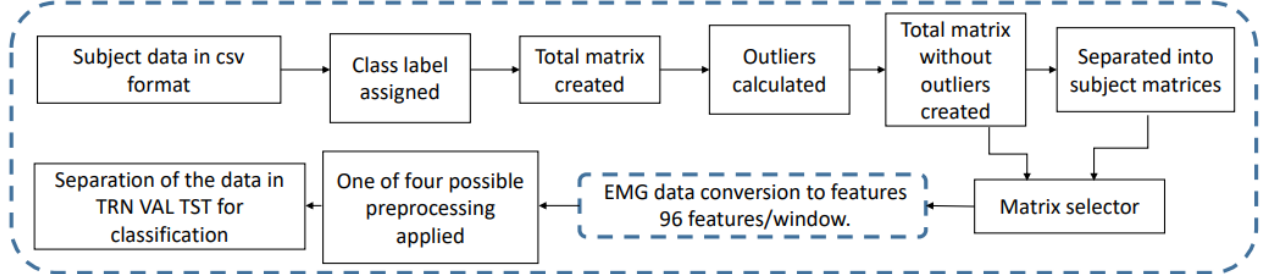
Figure 3. General sequence of data manipulation: from the database files to the preparation of feature matrices, before the experiments being carried out.